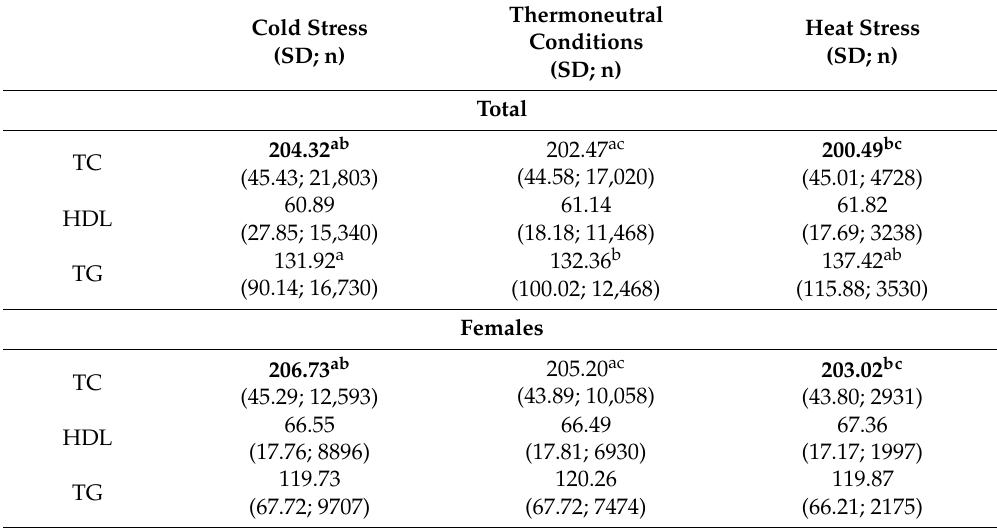
Table 3. Mean values (SD) and number of lipid parameters (mg%) and the universal thermal climate index (UTCI) depending on thermal